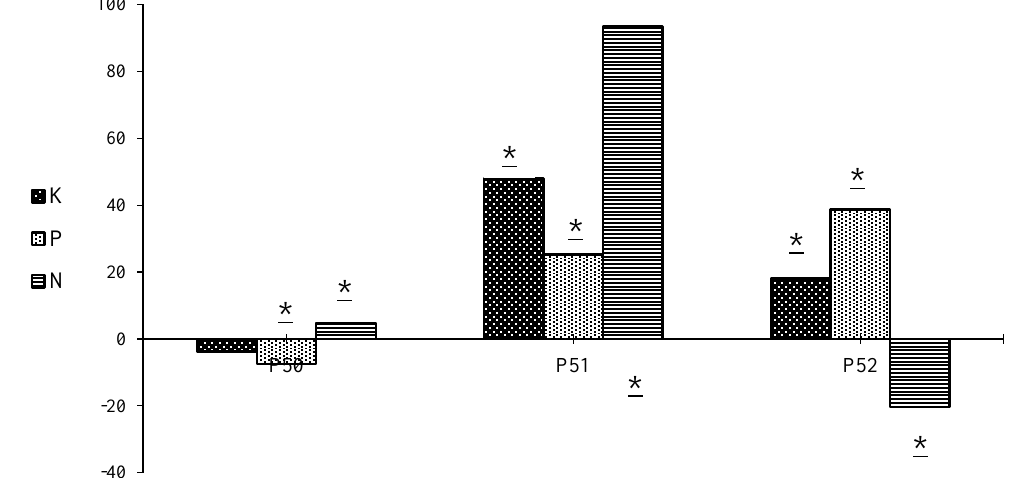
− 1 ). Di ff erence of t − t f 0 . * Statistically significant di